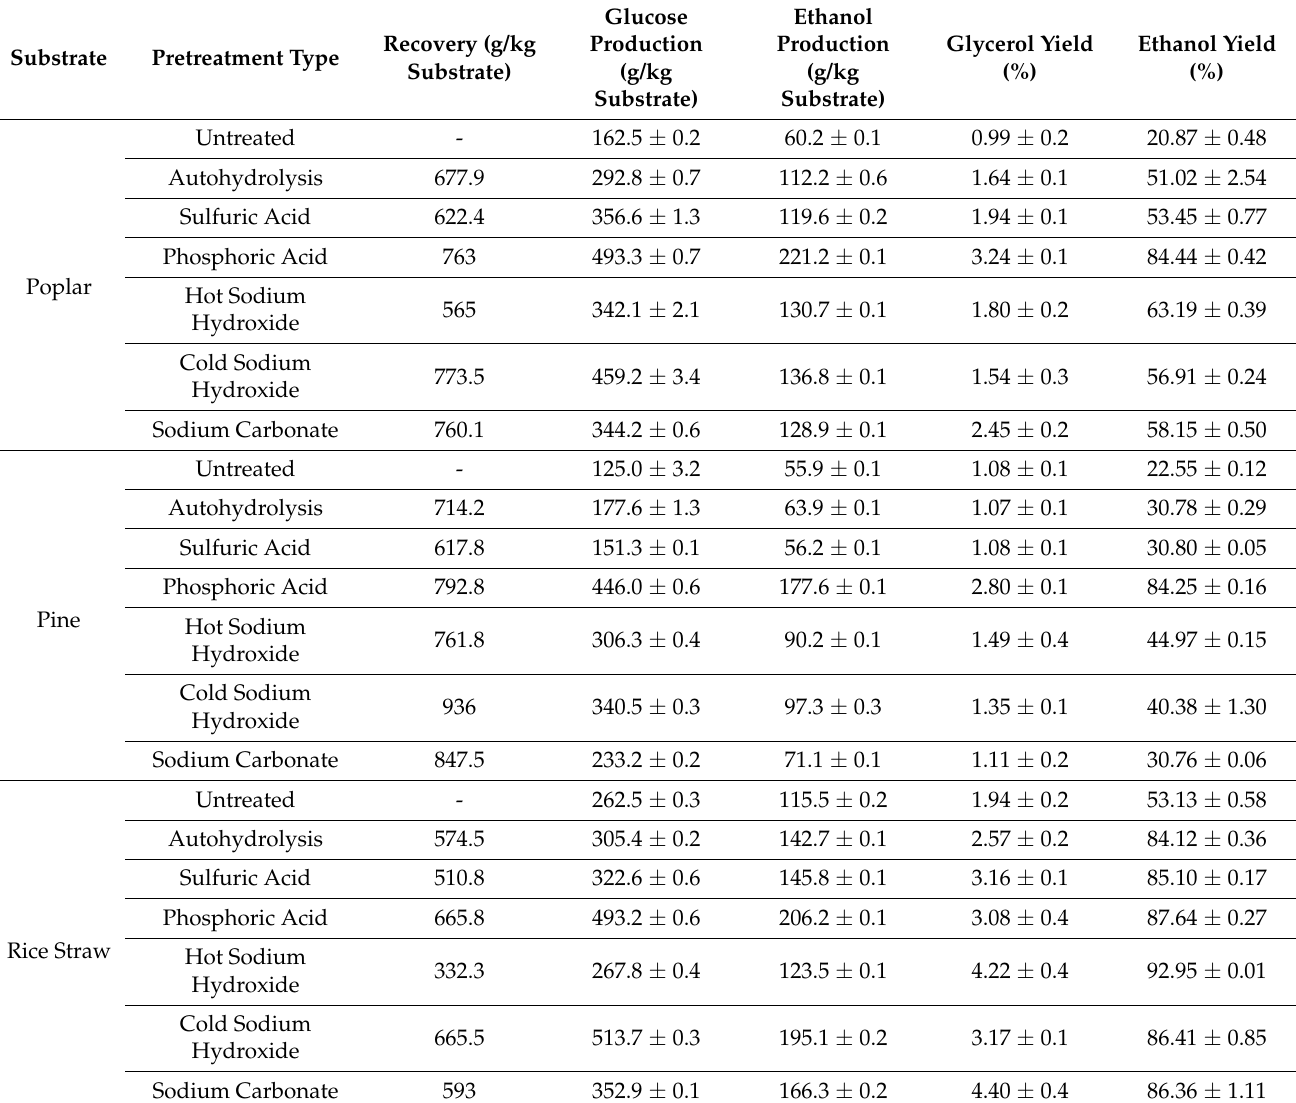
Table 4. Recovery (g per kg initial substrate), glucose production after enzymatic hydrolysis based on recovery (g per kg initial substrate), total ethanol production in SSF based on recovery (g per kg initial substrate), glycerol yield (%), and ethanol yield (%) for all untreated and pretreated